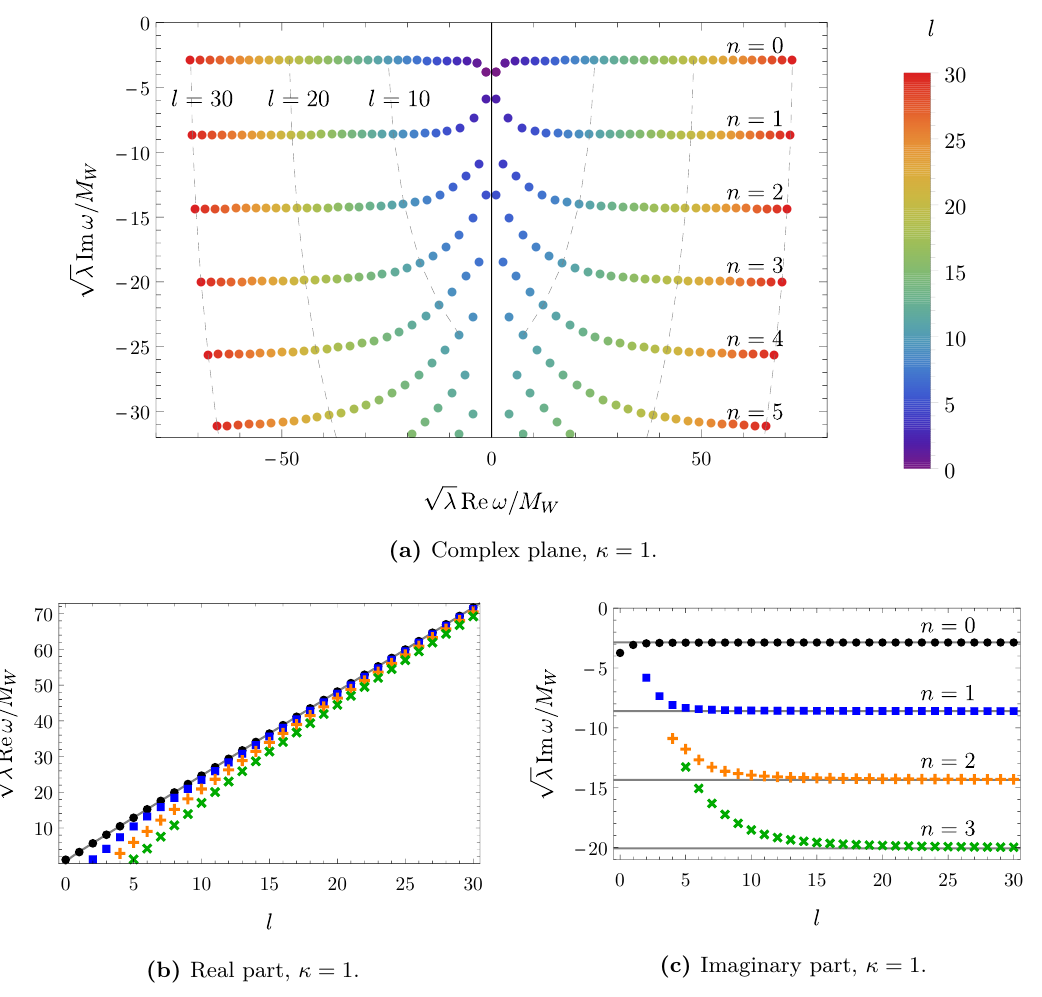
√ Figure 4. (a) QNM frequencies, in units of M W / λ , for κ = 1 and 0 ≤ l ≤ 30 , all obtained using Leaver’s method with 300 × 300 matrices. For clarity, we have not shown the purely imaginary QNM frequencies, which are present for all l . We have labelled the QNM frequencies by an overtone index n . The dashed grey lines are a guide to the eye, connecting QNM frequencies with the same value of l . (b, c) The real and imaginary parts of the first four overtones, as functions of l , for κ = 1 . The grey lines show the WKB approximation in eq. (4.6), which works well for l sufficiently large compared to n